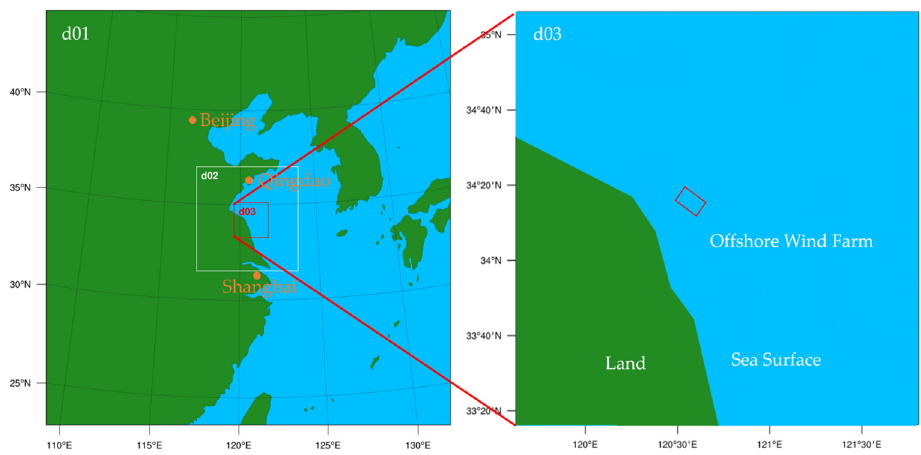
Figure 3. The domains of Case III and the relative location between the offshore wind farm and coastline.